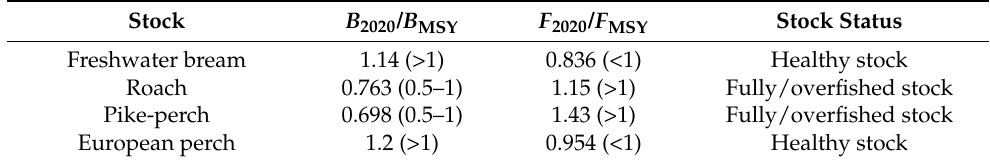
Table 6. The status of the stocks of species is determined from the combinations of B / B MSY and F / F MSY